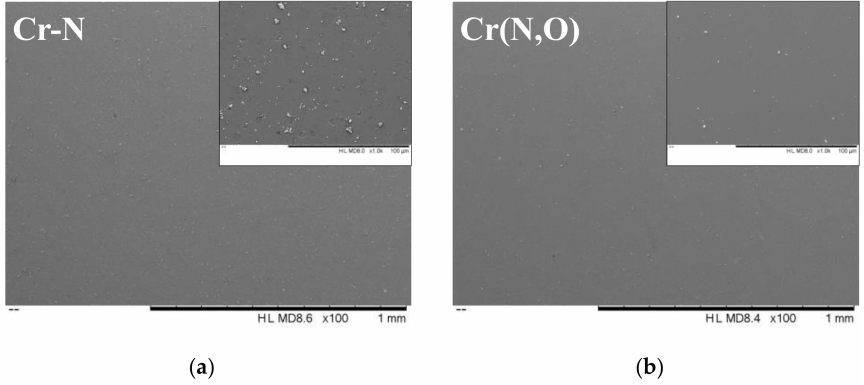
Figure 1. SEM micrographs of the investigated monolayers before the corrosion tests: ( a ) Cr–N; ( b ) Cr(N,O).